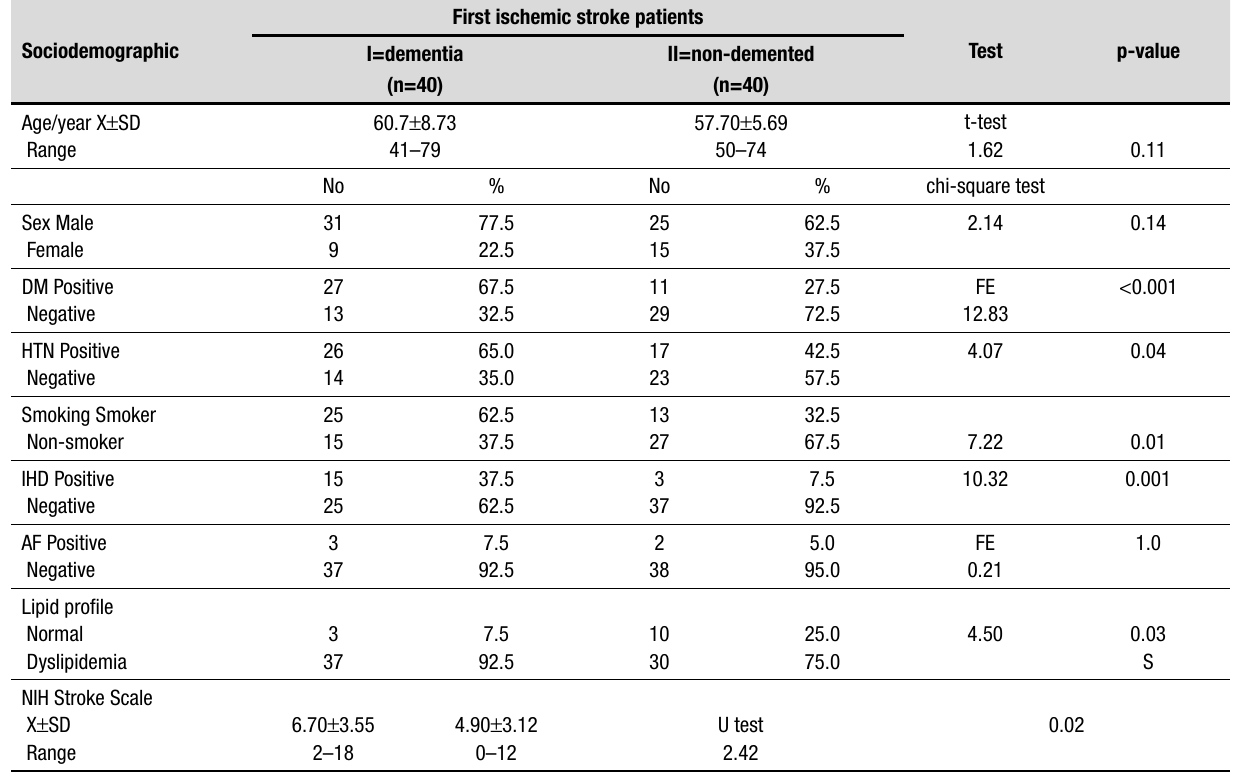
Table 1. Demographic and clinical characteristics of first stoke patients with and without dementia. Sociodemographic